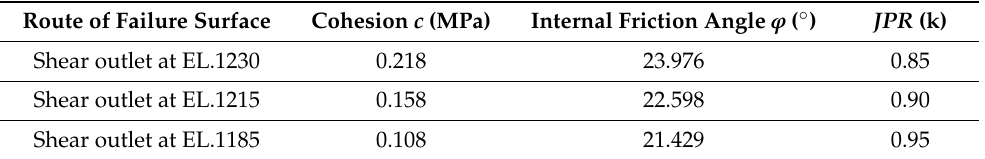
Table 4. Three dimensional discrete element numerical inversion results. Route of Failure